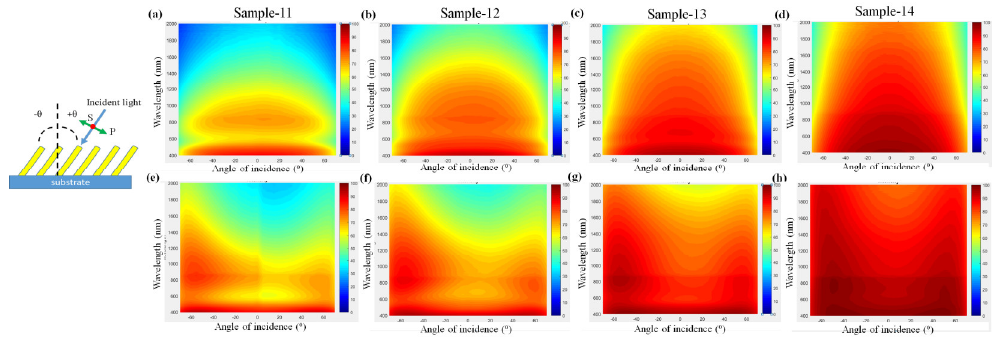
Figure 7. Measured ( a – d ) s-polarized and ( e – h ) p-polarized extinctance versus wavelength and angle of incidence for TiN NRA. Plane of incidence and the incident angle of θ are shown.